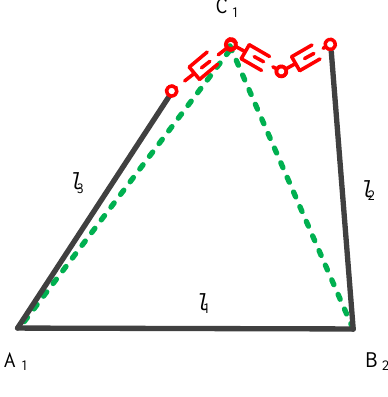
Figure 13. The position of C 1